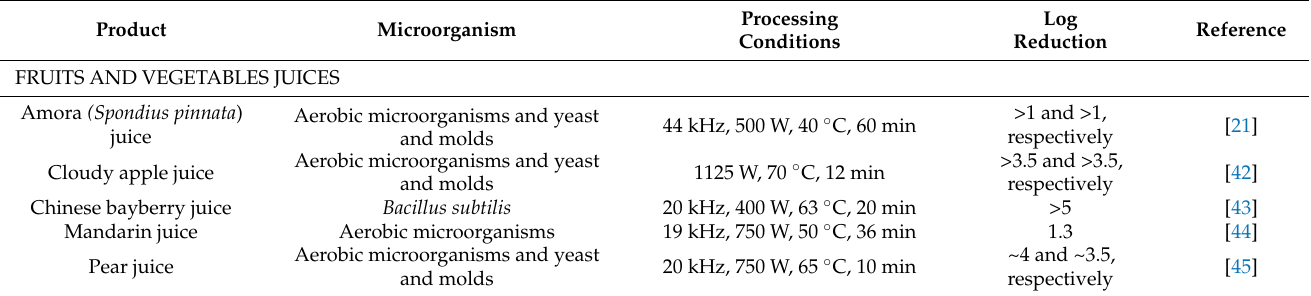
Table 1. Microbial inactivation in food products using